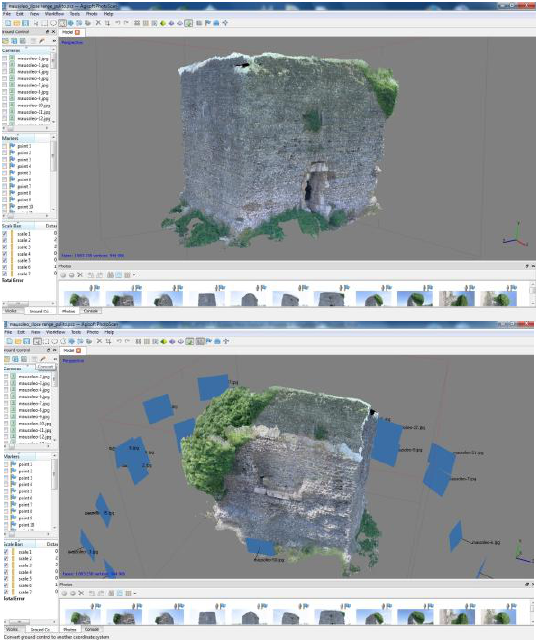
Figure 3. Photogrammetric data processing by Agisoft Photoscan.